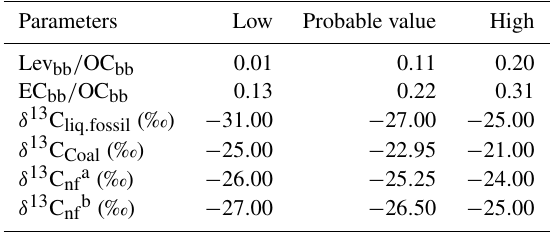
a Values used in BJ/LF. b Values used in XA. The parameters in Table 1 are referenced from Agnihotri et al. (2011), Engling et al. (2006, 2009), Gelencsér et al. (2007), Huang et al. (2006), López-Veneroni (2009), Martinelli et al. (2002), Moura et al. (2008), Oros et al. (2001a, b), Puxbaum et al. (2007), Smith and Epstein (1971), Szidat et al. (2006), Turekian et al. (1998), Wang et al. (2009), Widory (2006), and Zhang et al.